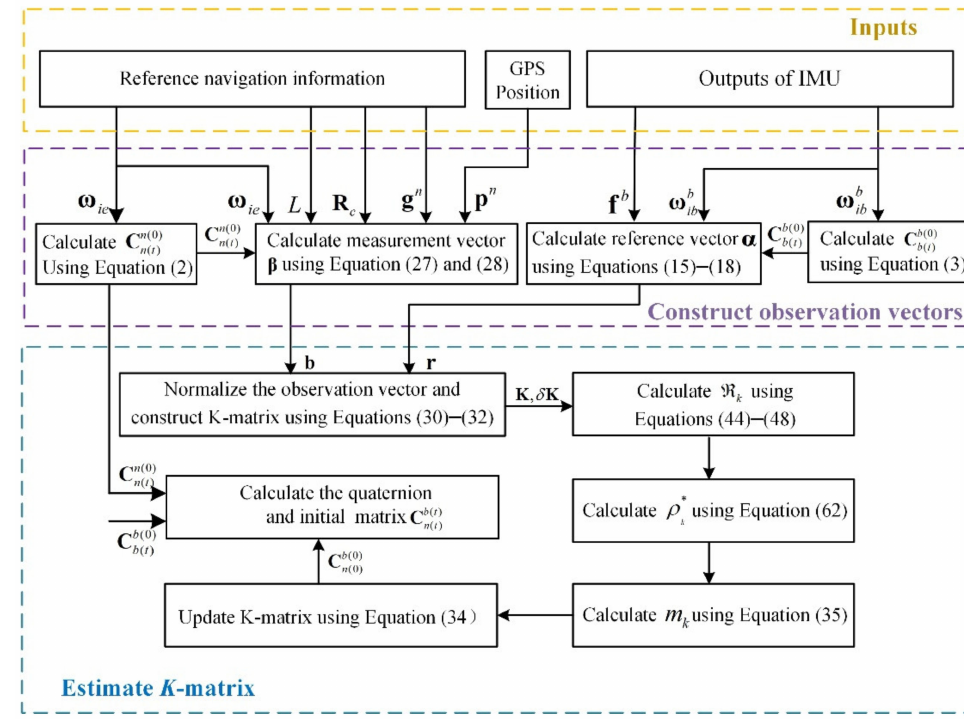
Figure 1. In-motion coarse alignment